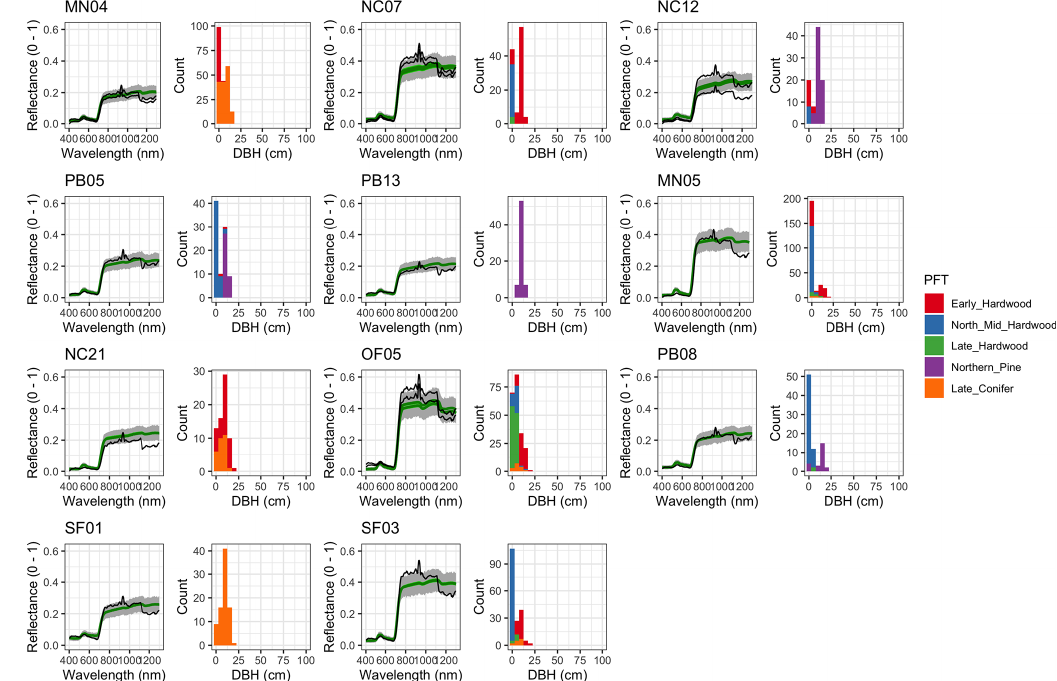
Figure A7. EDR-predicted vs. observed spectra and species composition for the first quartile of sites by DBH.